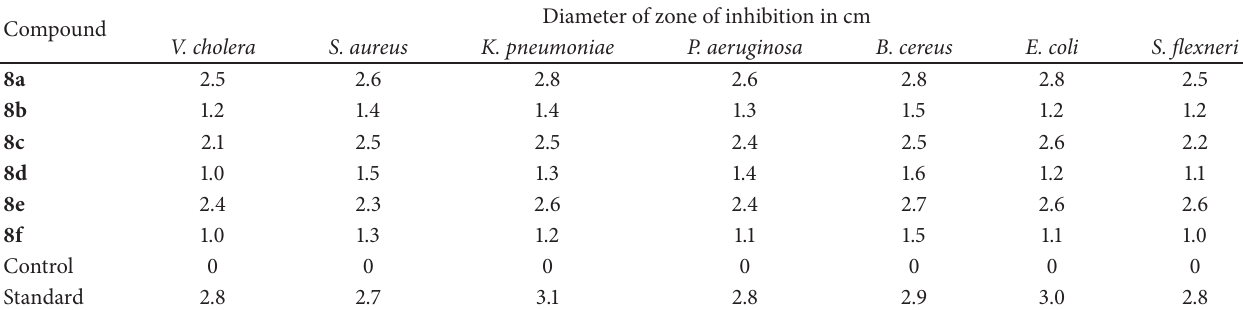
Table 2: Antibacterial activity of compounds 8(a–f) .